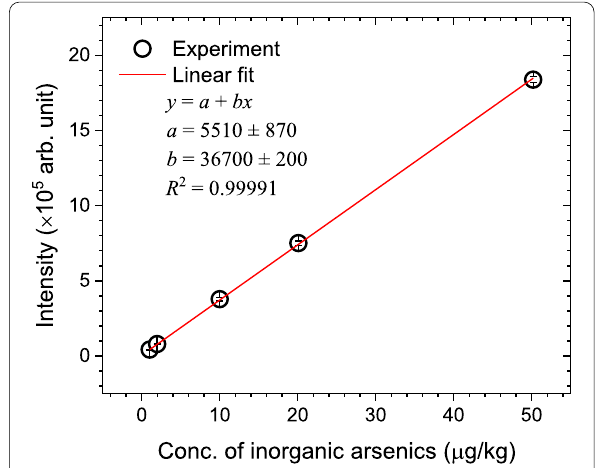
Fig. 3 Calibration curve of inorganic